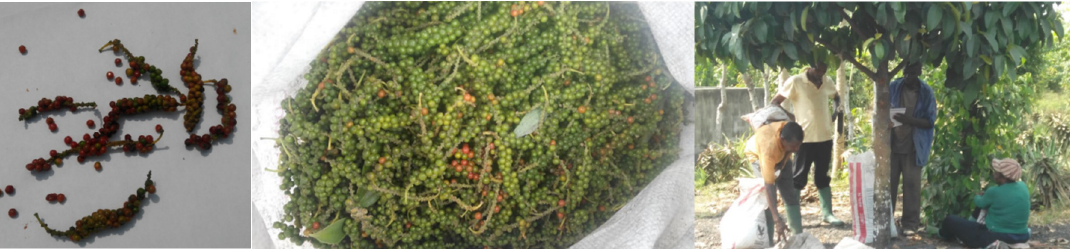
Figure 4. Drying pepper in sunlight (Njombe, Cameroon).